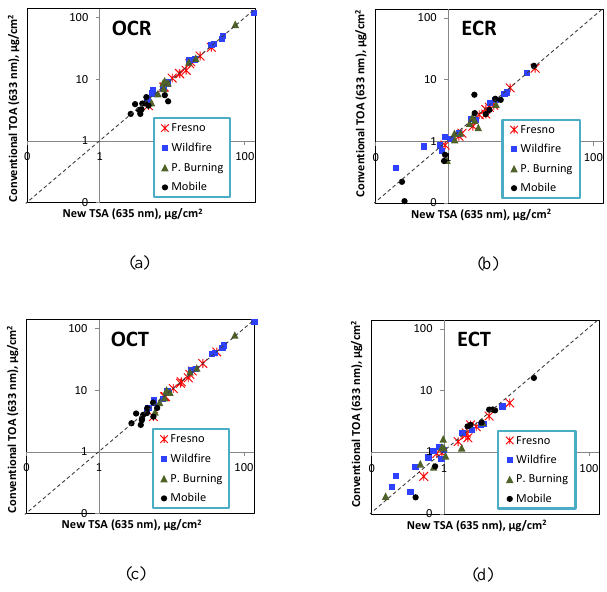
Figure 2. Calibration of spectral laser (a, b) reflectance and (c, d) transmittance measurements (LR λ and LT λ , respectively, in milli- volts (mV)) from the retrofitted seven-wavelength carbon analyzer at room temperature against absolute filter reflectance and trans- mittance (FR λ and FT λ , respectively) quantified by the Lambda integrating-sphere spectrometer, using eight Fresno ambient sam- ples (5 / 6, 6 / 6, 6 / 19, 7 / 3, 9 / 29, 11 / 4, 11 / 13, and 12 / 28 of 2003) of various loadings as transfer standards. The 633nm data are from a conventional carbon analyzer. r 2 and CV-RMSR evaluate the re- gression performance.